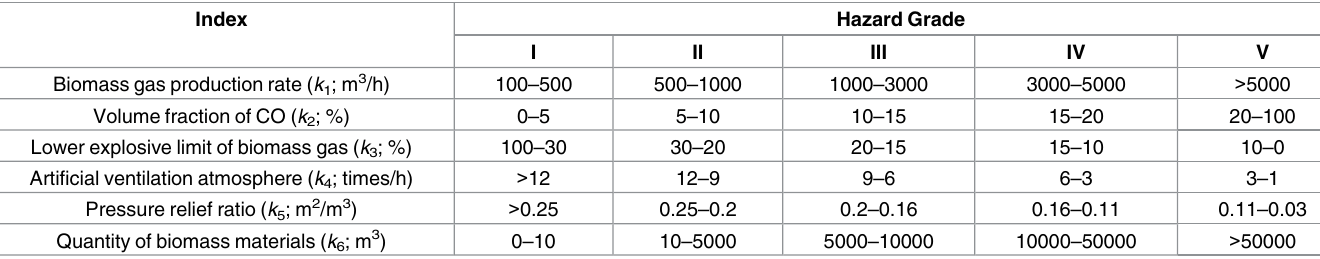
Table 5. Classification of hazard